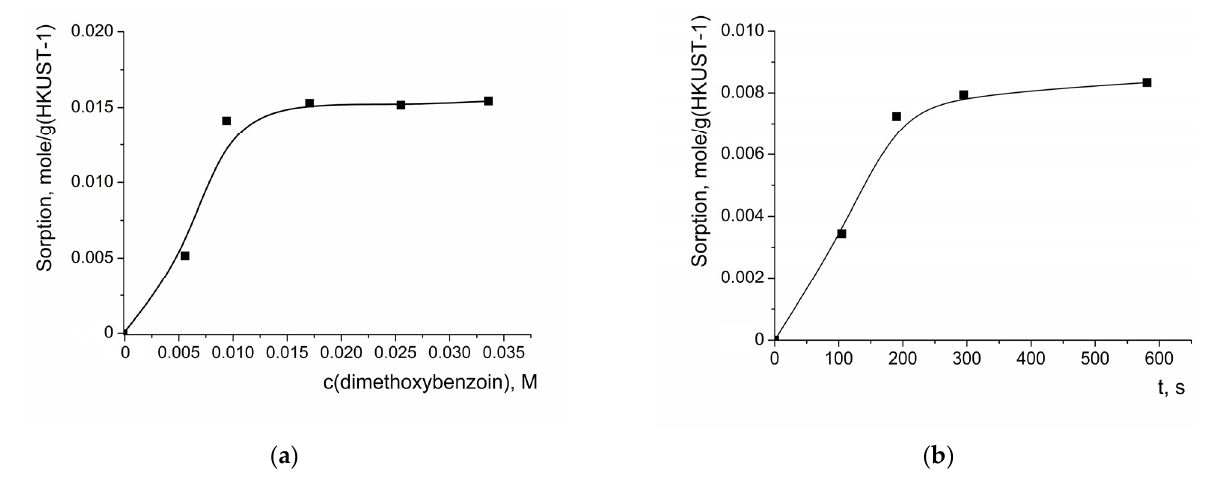
Figure 13. Isotherm of 4,4-dimethoxybenzoin adsorption on HKUST-1 ( a ) and kinetic curve of this compound adsorption (c 0 = 0.0165 M) ( b ).